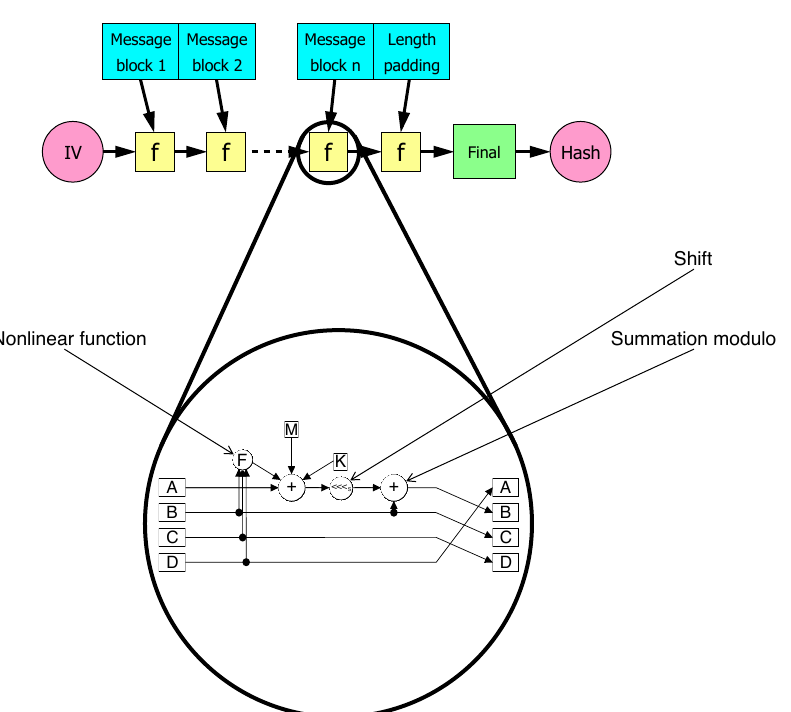
Figure 2. Dividing MD5 hashing to “simple” problems. The circles denote operations and rectangles indicate integer